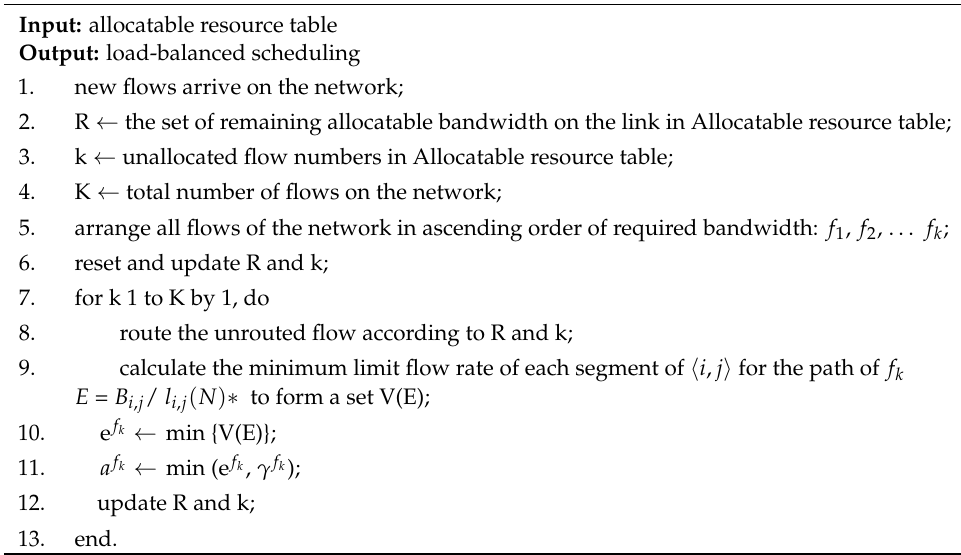
Algorithm 2. Static Routing Network